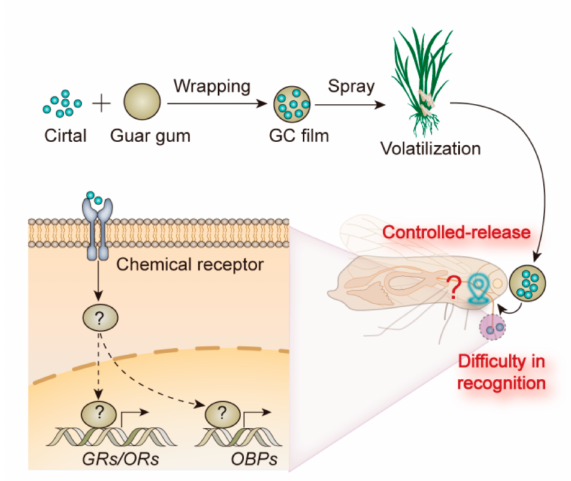
Figure 10. Schematic plot for repellency mechanism of GC film on BPHs. The citral was wrapped by guar gum and made into GC film. Then, rice was sprayed with film-forming emulsion of GC film. By the way of controlled release of citral, GC film influenced the recognition of BPHs to rice. Further, the citral, which is the main active constituent of GC film, affected expression of OBPs gene and GRs/ORs gene levels, resulting in interference in the recognition and localization of